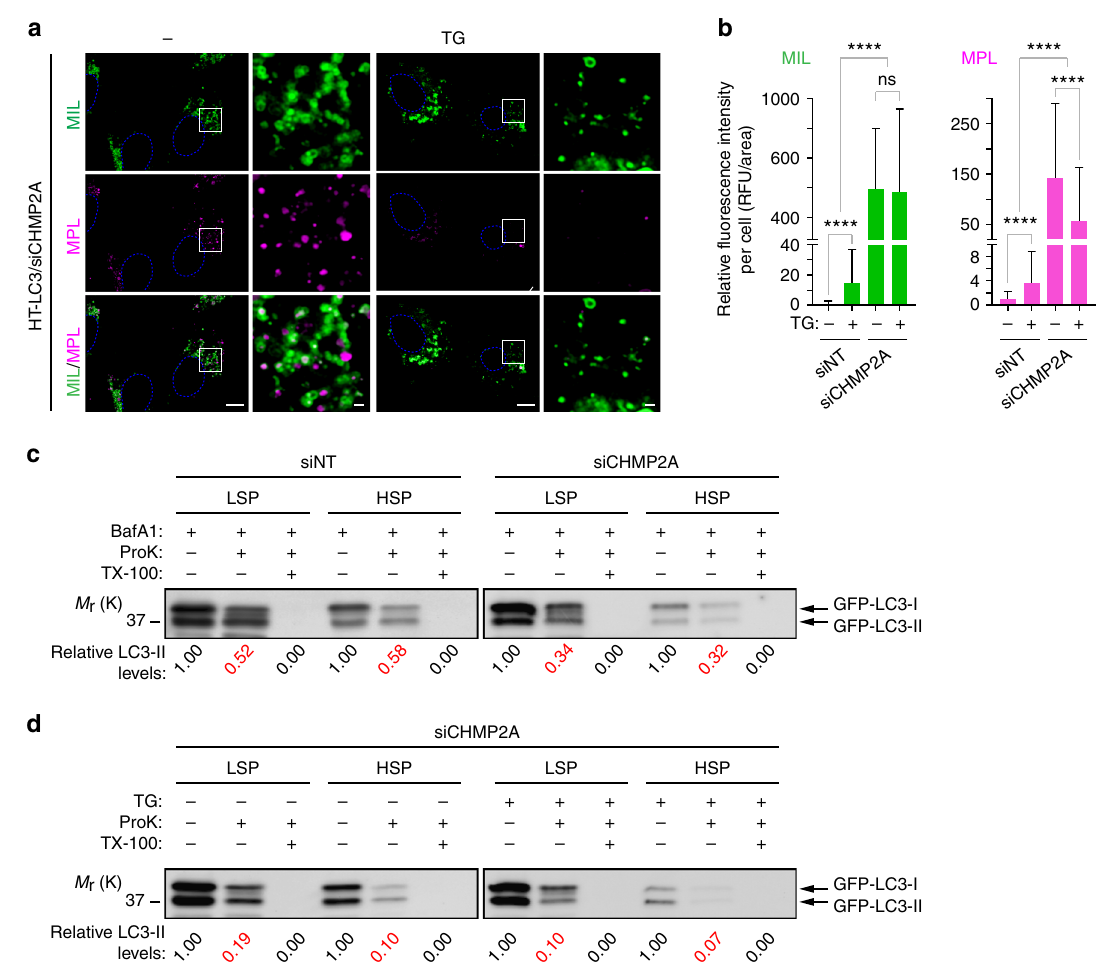
Fig. 8 The SERCA inhibitor thapsigargin further accumulates unclosed autophagosomal membranes in CHMP2A-depleted cells. HT-LC3- ( a , b ) and GFP- LC3-expressing ( c, d ) U-2 OS cells were transfected with the indicated ON-TARGETplus SMART Pool siRNAs for 48 h. The indicated inhibitors (100 nM thapsigargin (TG); 100 nM BafA1) were added in the last 18 h of culture. a Cells were subjected to the HT-LC3 autophagosome completion assay followed by confocal microscopy. The scale bars represent 10 μ m and 1 μ m in the magni fi ed images. b The cytoplasmic fl uorescence intensities of MIL and MPL per cell in ( a ) were quanti fi ed and normalized to the respective mean fl uorescence intensities of control siNT-transfected cells ( n > 130). Data shown are representative of two independent experiments. Statistical signi fi cance was determined by Kruskal – Wallis one-way ANOVA on ranks followed by Dunn ’ s multiple comparison test. All values are mean ± SD. ns not signi fi cant; **** p ≤ 0.0001. c , d The low-speed pellet (LSP) and high-speed pellet (HSP) prepared from the postnuclear supernatant were resuspended in homogenate buffer in the presence or absence of proteinase K (ProK) and Triton X-100 (TX-100) and subjected to the proteinase K protection assay followed by immunoblotting using an anti-LC3 antibody. The LC3-II levels